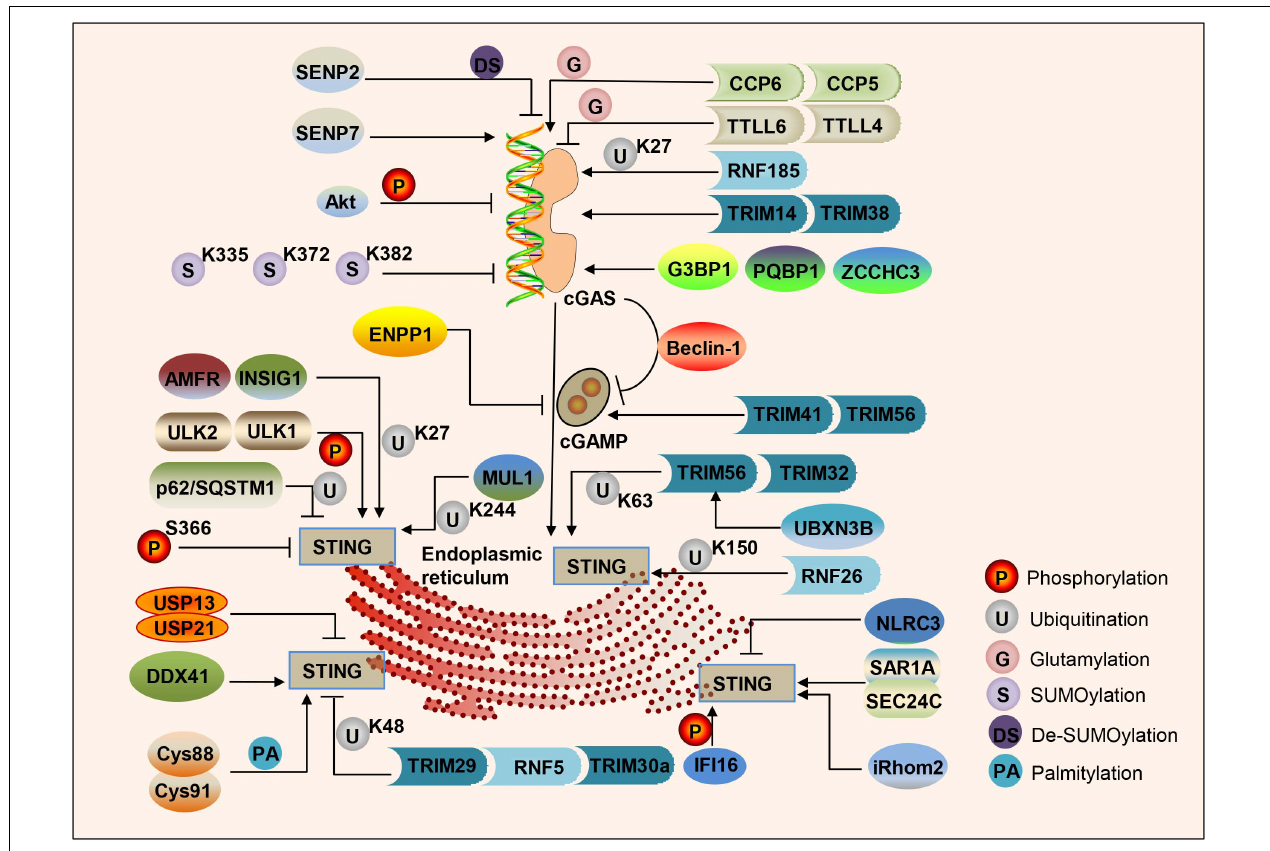
FIGURE 2 | Regulation of the cGAS-STING pathway of cytosolic DNA sensing. cGAS, cGAMP and STING are dynamically regulated by various modifications in response to DNA attacks, such as phosphorylation, ubiquitination, SUMOylation, glutamylation, palmitoylation, and the protein–protein binding in